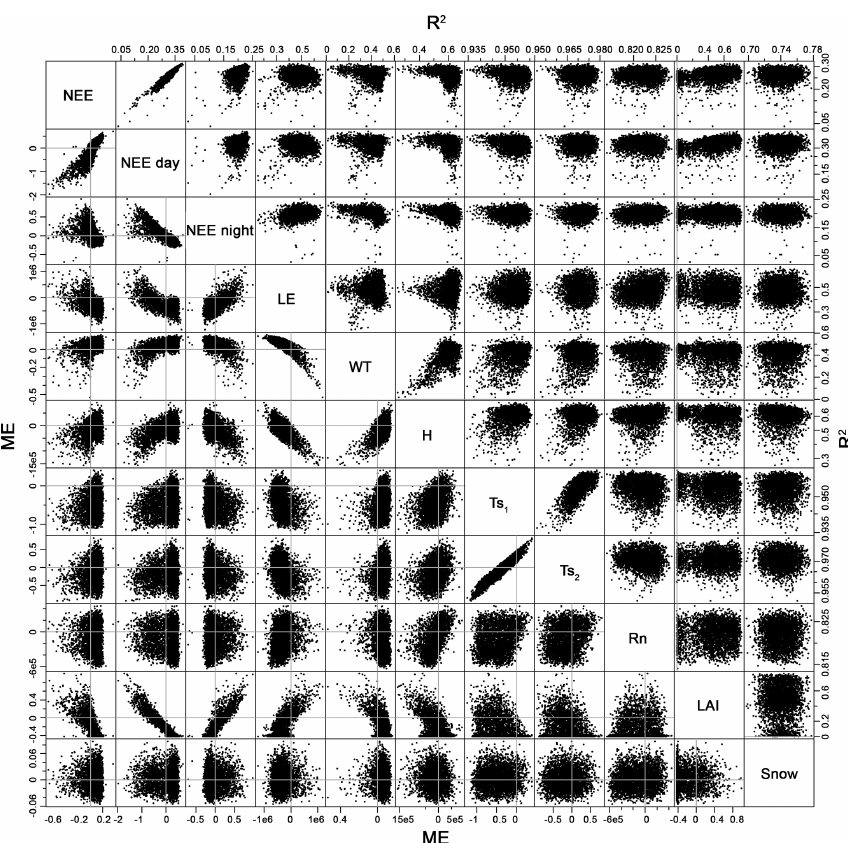
Figure 5. Correlations between performance indices in the prior distribution (3200 random runs): R 2 vs. R 2 (upper panel); mean error (ME) vs. ME (lower panel). Each of the dots represents a parameter set. Grey lines indicate the axes through